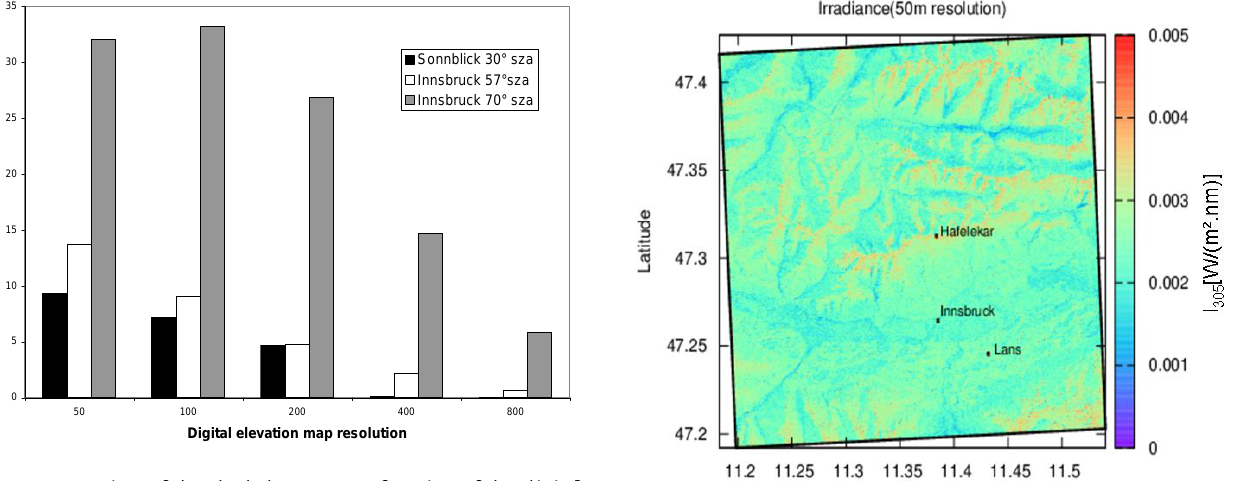
Fig. 4. Overview of the shaded areas as a function of the digital elevation map resolution. The simulations were performed using the digital elevation maps of the Innsbruck and Sonnblick regions. For the “Innsbruck” simulations, solar zenith angles of 57 and 70 degree were used and for the “Sonnblick” simulations a solar zenith angle of 30 degrees was used.